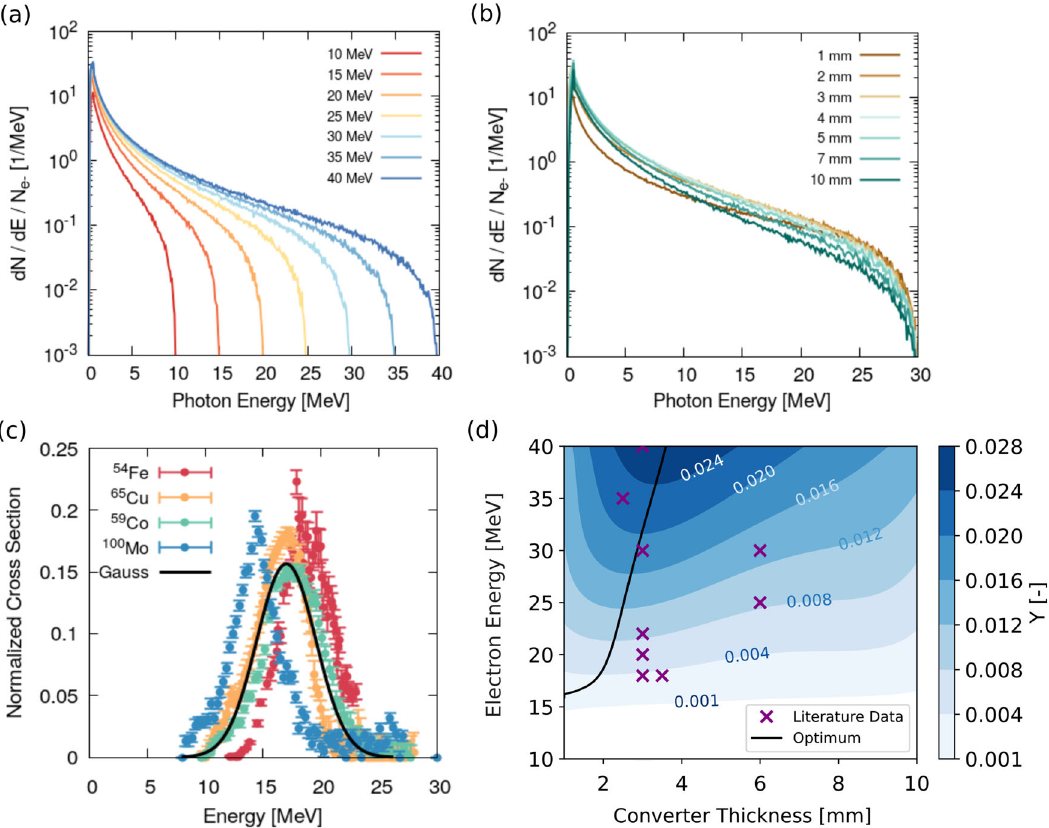
Fig. 2 Parametric scan and model results for photon activation analysis (PAA). a Photon energy spectra from Fluka simulations for different values of the primary electron energy and fi xed converter thickness (i.e., 3 mm). b Photon energy spectra from Fluka simulations for different values of the converter thickness and fi xed primary electron energy (i.e., 30 MeV). The spectra are normalized to the total number of primary electrons. c Comparison between a Gaussian function centered in 17 MeV, FWHM = 7 MeV and normalized experimental photonuclear cross sections. Both absolute values and uncertainties are retrieved from the ENDF database 67 and then normalized to the area subtended by the cross sections. d Contour plot showing the normalized yield as a function of the primary electron energy and converter thickness. The black line marks the locus of optimal converter thickness, while the purple markers correspond to working points from the literature 56,68 – 74